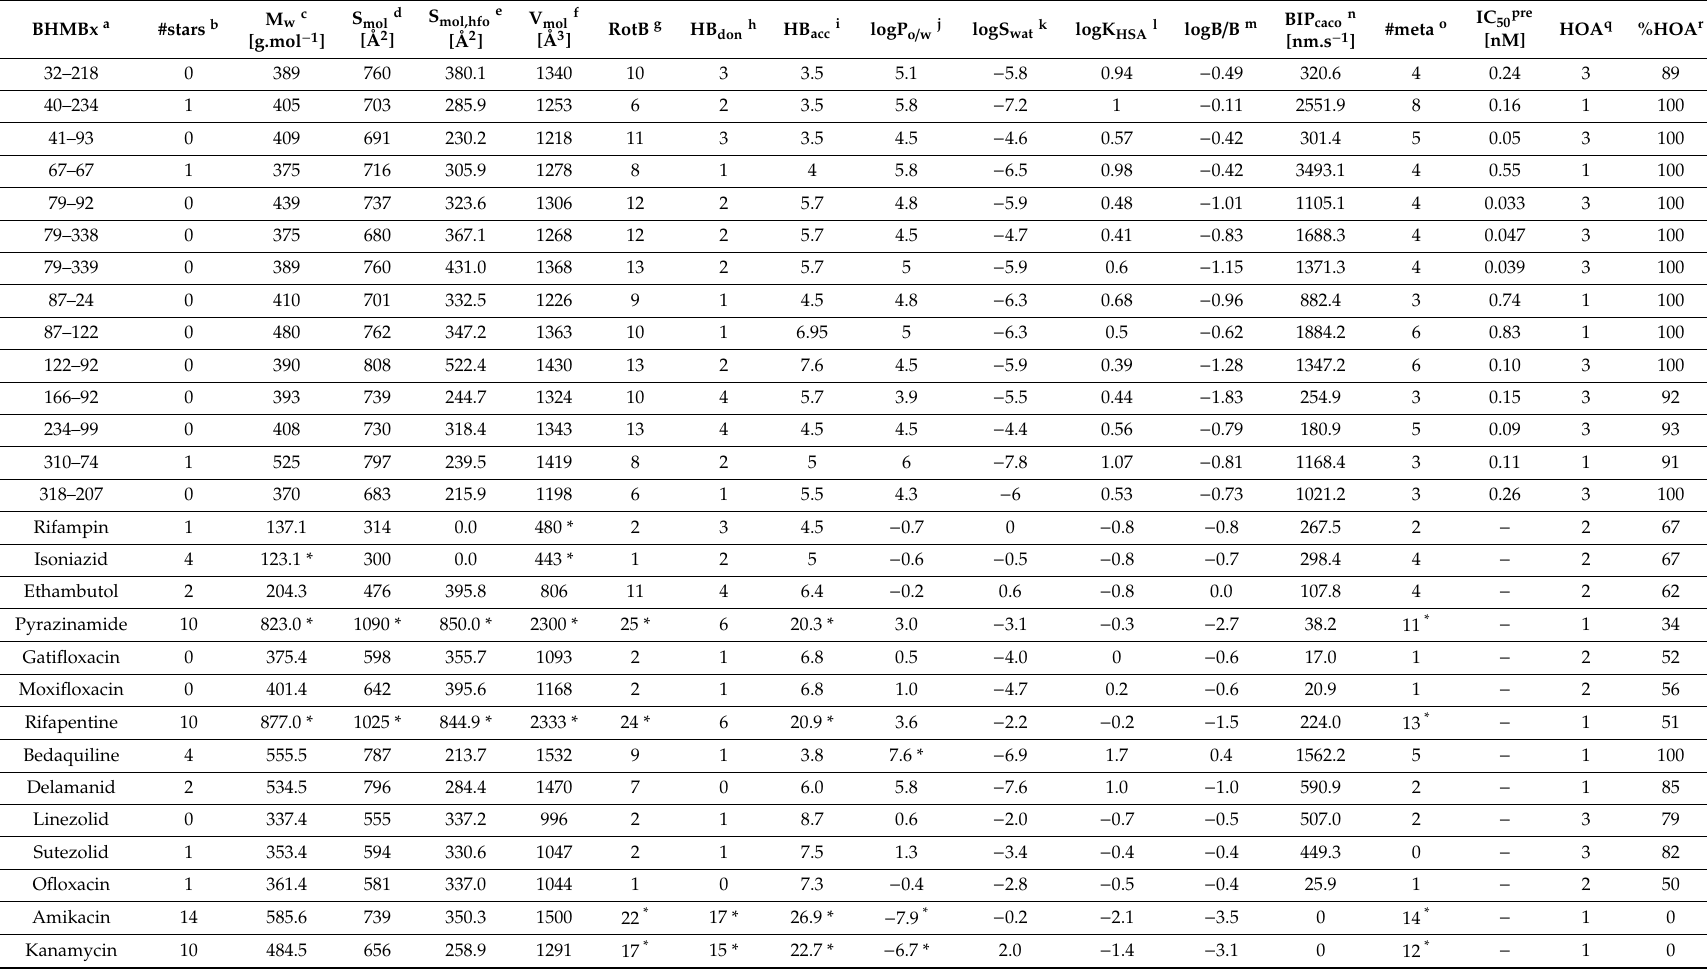
Table 7. ADME-related properties of the best designed BHMB analogs and known antituberculotic agents either in clinical use or currently undergoing clinical testing computed by QikProp